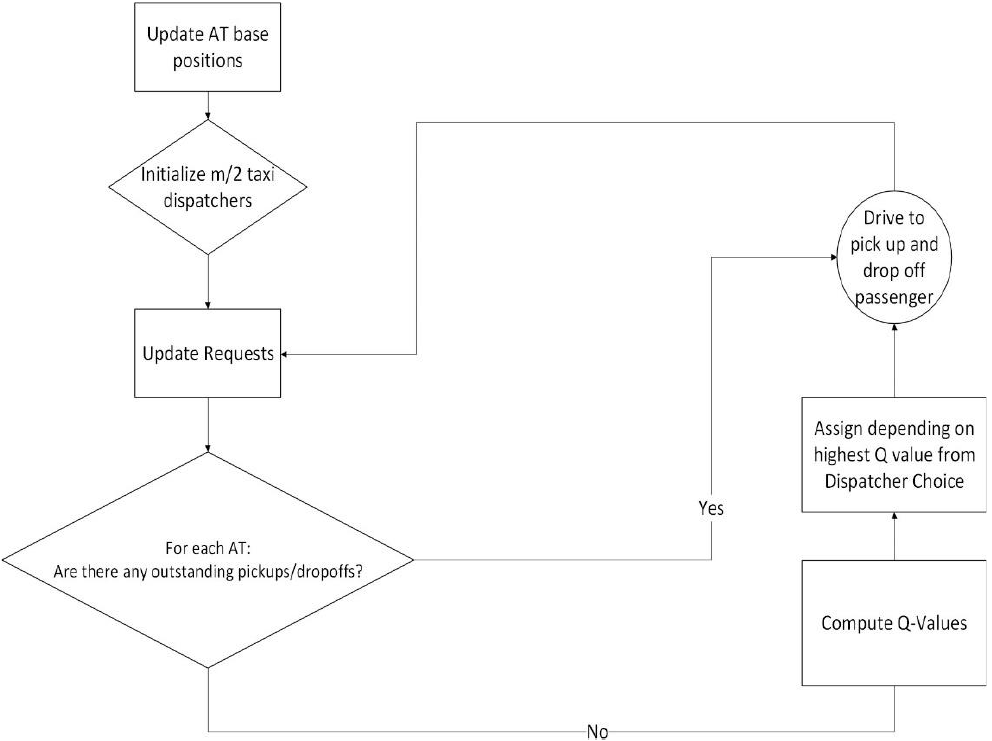
Figure 18. RL SAV dispatcher.